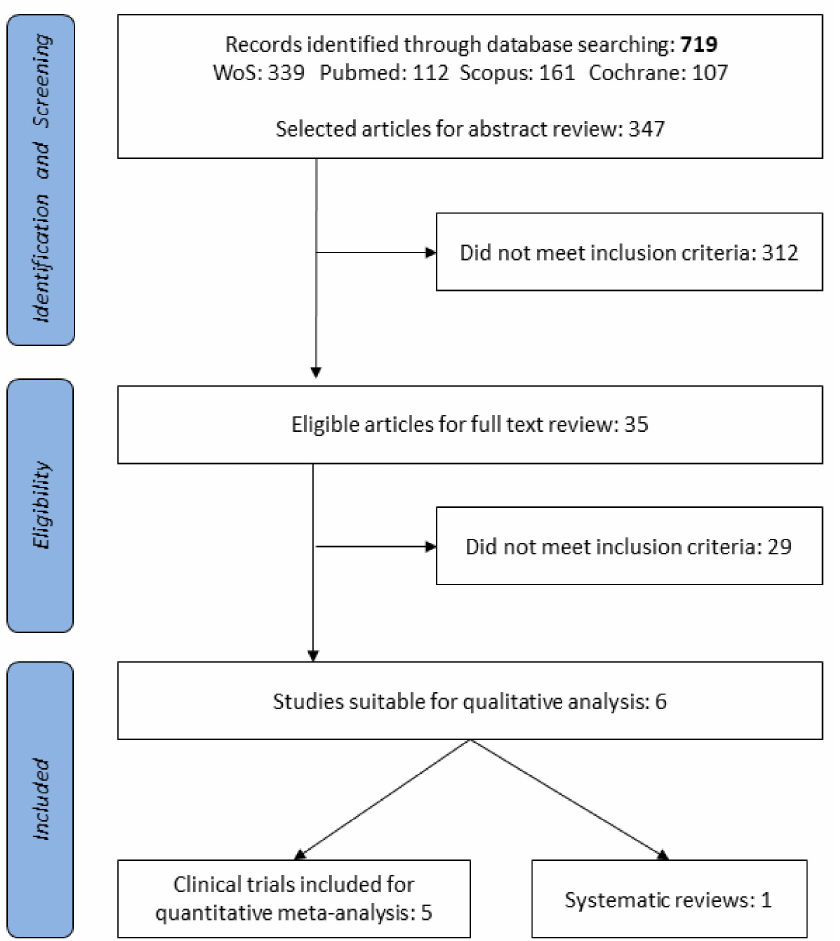
Figure 2. Vaginal probiotics Preferred Reporting Items for Systematic Reviews and Meta-Analyses (PRISMA). Complementary oral probiotics PRISMA was previously performed